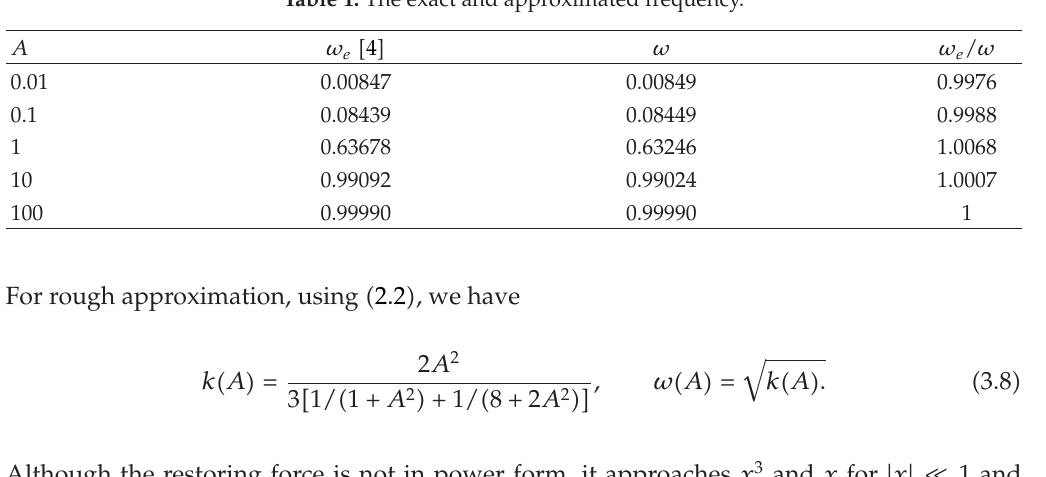
Table 1: The exact and approximated